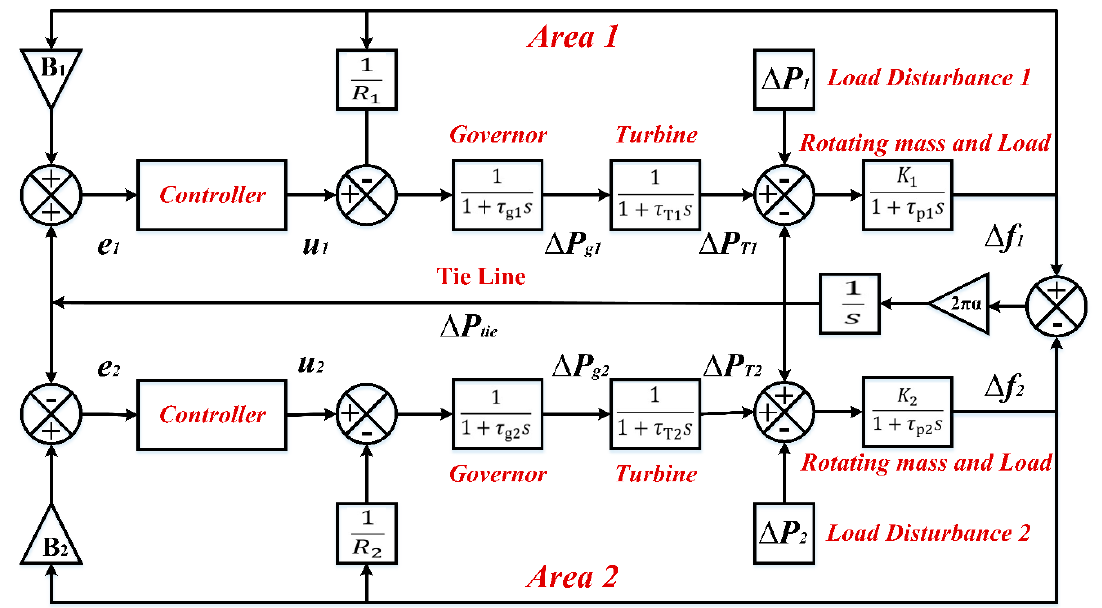
Figure 6. The block diagram of a two-area PSN based on a transfer function. Table 2. Nomenclatures of the